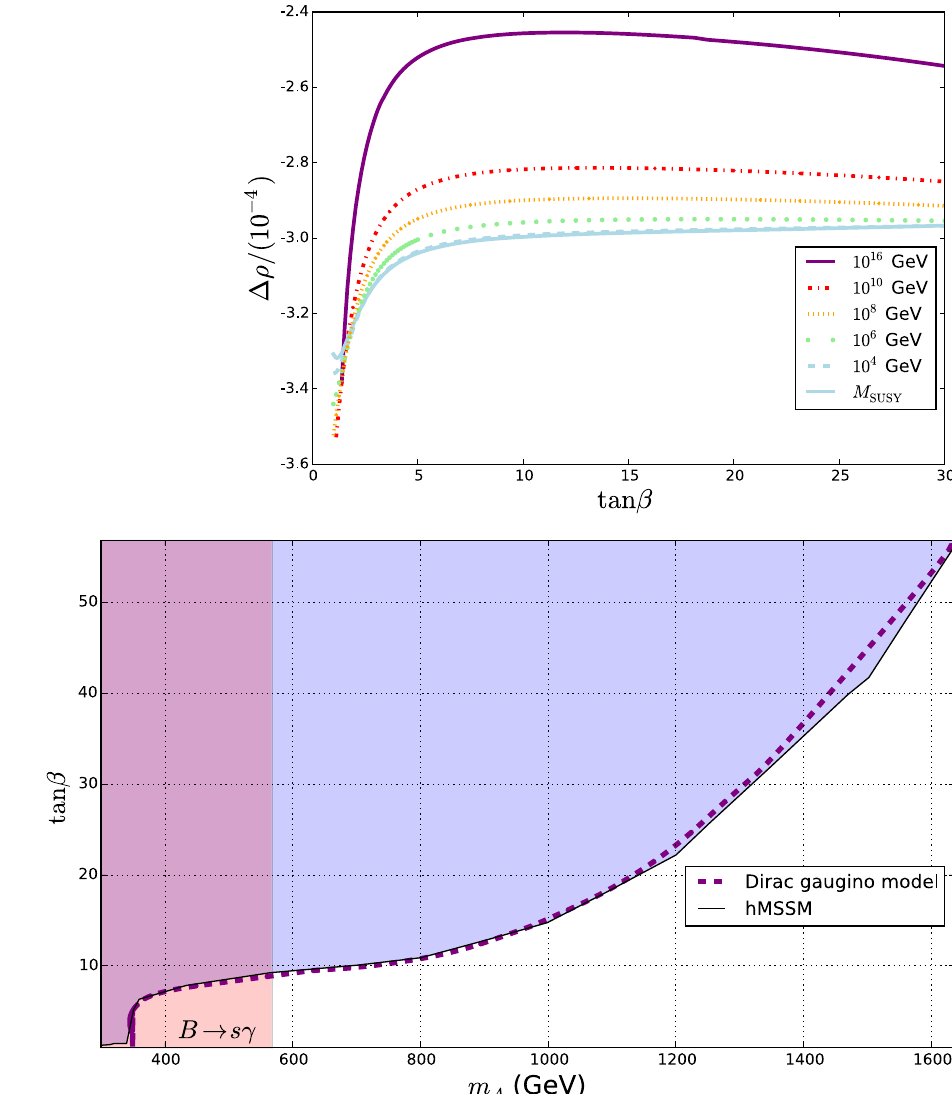
Fig. 8 Bounds from pp → H / A → τ + τ − (blue region) and B → s γ (red region, m A (cid:3) 568 GeV) interpreted in the m A / tan β plane for the hMSSM (taken from [90]) and our